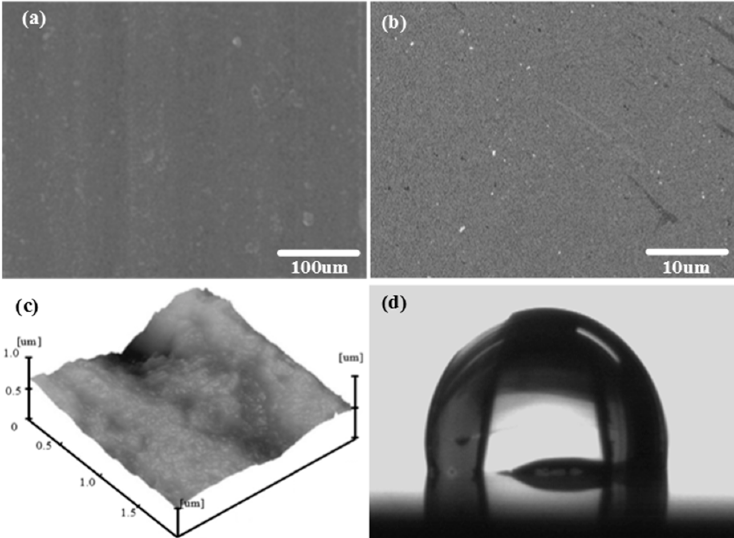
Figure 2. Images of scanning electron microscope (SEM), atomic force microscope (AFM) and a water droplet on the untreated aluminum alloy. ( a ) SEM image with 200 magnification; ( b ) SEM image with 2000 magnification; ( c ) AFM image; ( d ) water droplets with a volume of 5 μ L.